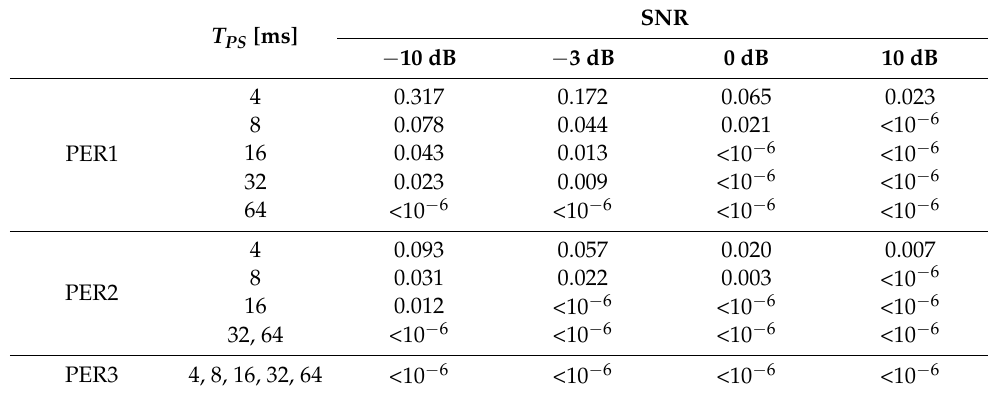
Table 4. Preamble Error Rate (PER) values for different values of T PS and SNR—channel NCS1.